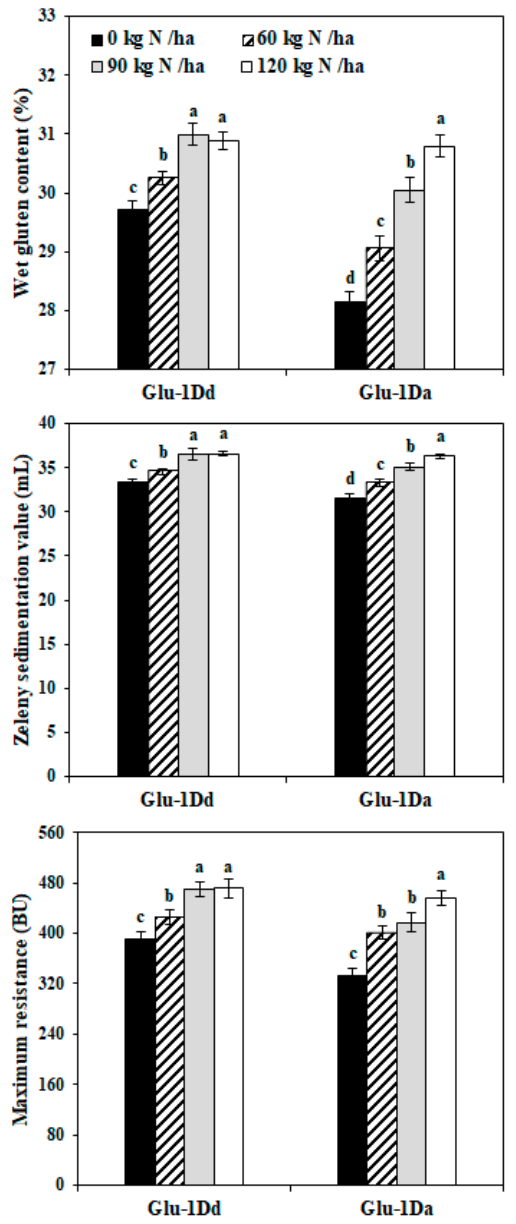
Figure 1. Grain quality traits in the wheat lines with Glu-1Dd and Glu-1Da under the application of N fertilizer. Same letter in the different columns for each material indicate no significant difference ( p > 0.05). Data are presented as the mean of two years.